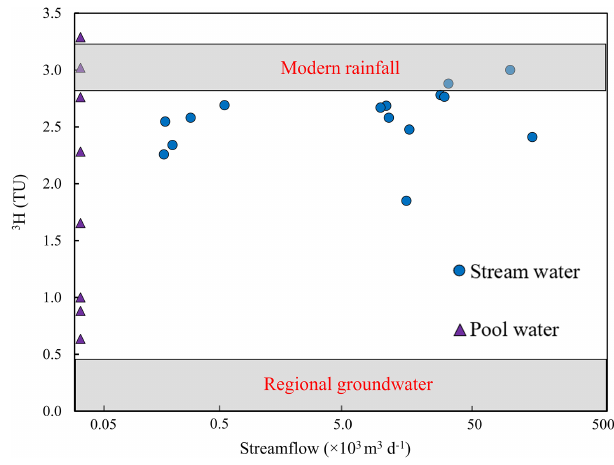
Figure 7. Variation of 3 H activities and streamflow. Pool water rep- resents a time of zero streamflow. Shaded areas show 3 H range of modern rainfall and regional groundwater. Data from Table